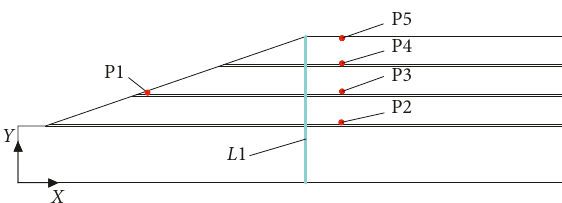
Figure 12: Distribution graph of key positions.